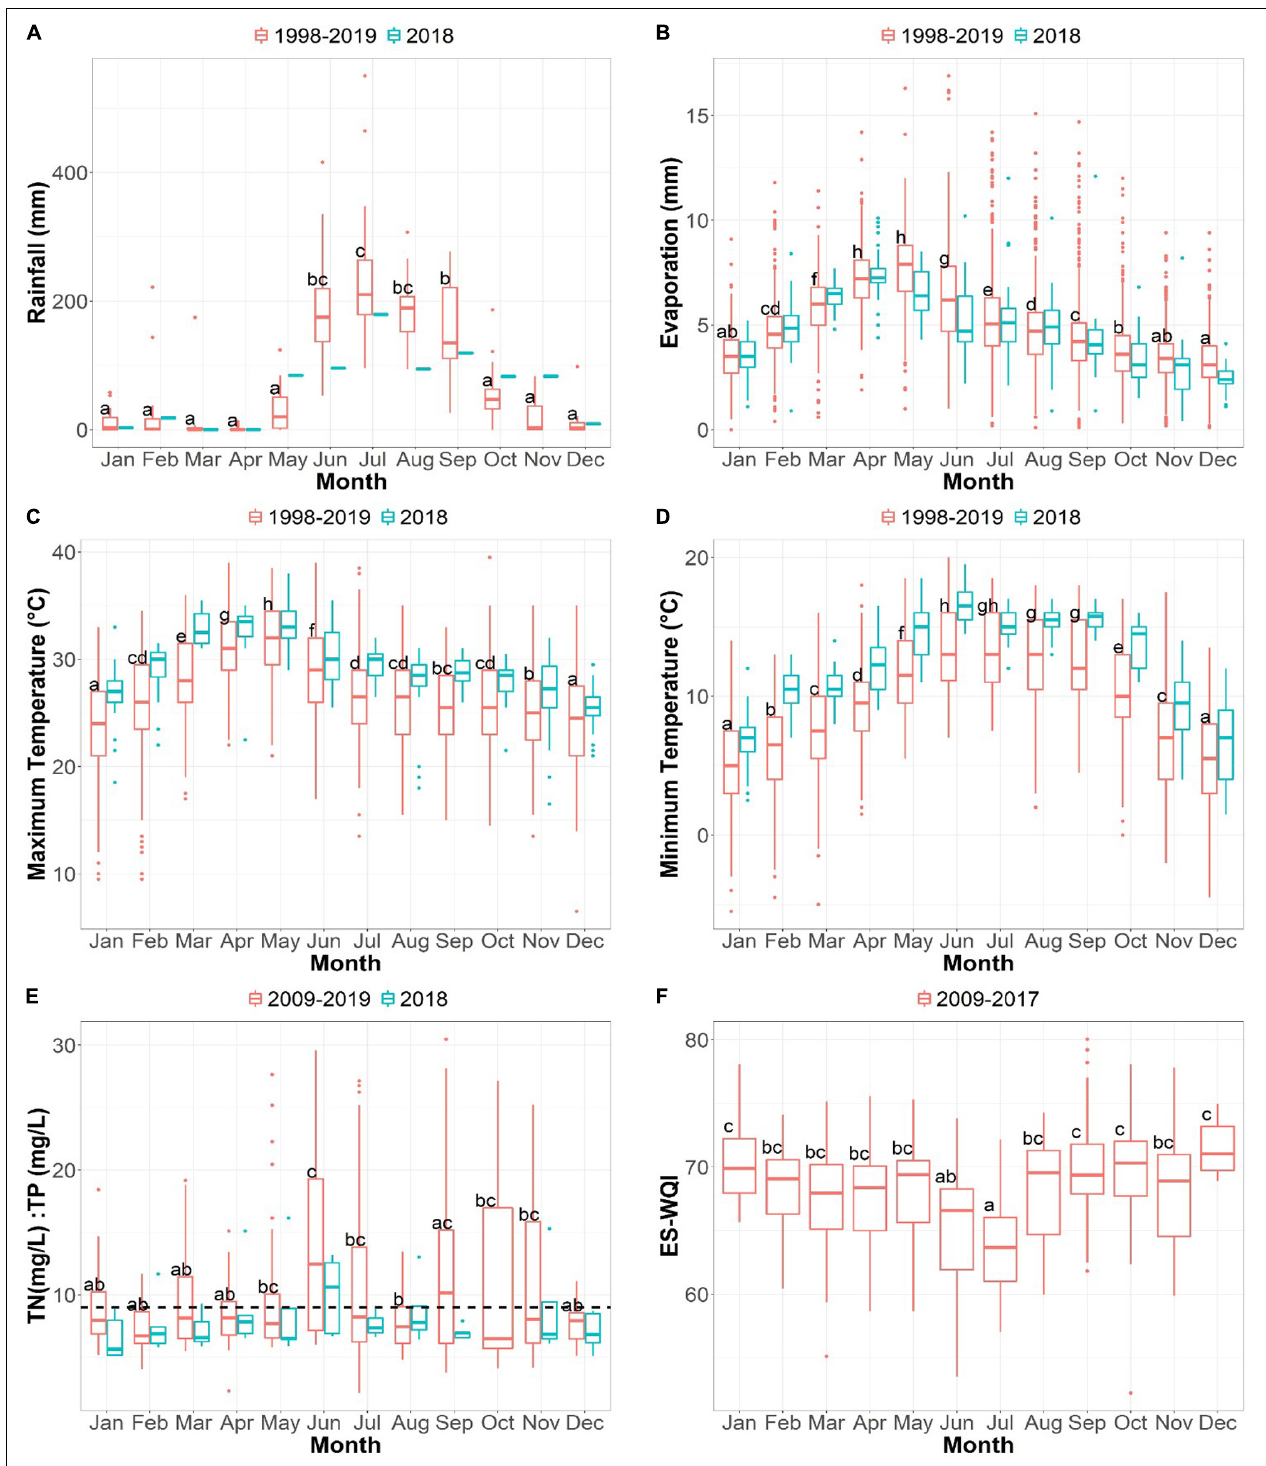
FIGURE 2 | Annual behavior of the mean temperature ( ◦ C) (maximum and minimum), rainfall (mm), and evaporation (mm) of Lake Cajititlán over a 21 years period (1998–2019). Annual behavior of the ecosystem-specific water quality index (ES-WQI) of Lake Cajititlán in the period 2009–2017. Annual behavior of the mean TN:TP ratio in Lake Cajititlán over a 10 years period (2009–2019). (A) Rainfall (mm). (B) Evaporation (mm). (C) Maximum temperature ( ◦ C). (D) Minimum temperature ( ◦ C). (E) TN:TP ratio (mg/L). (F) ES-WQI.